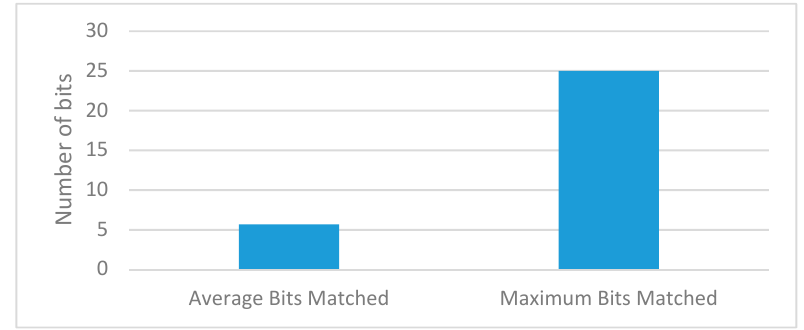
Figure 35. AnyLogic Statistics for Bits Verifications in PoG.